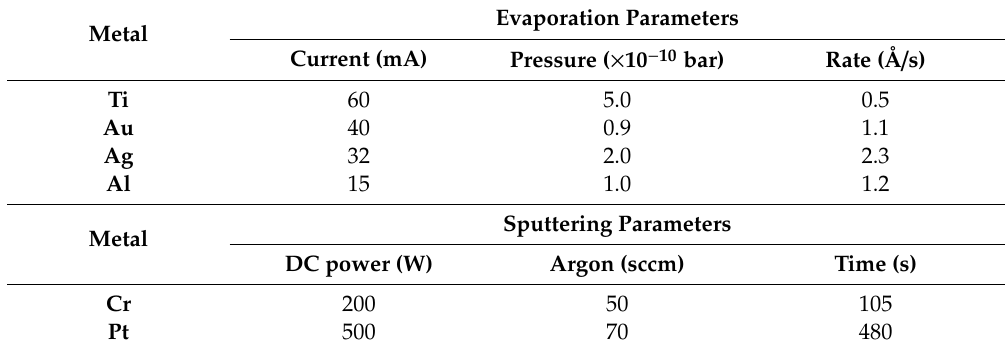
Table 1. The parameters used for metal deposition by sputtering (Cr, Pt) and evaporation (Ti, Au, Ag, Al). Evaporation Metal